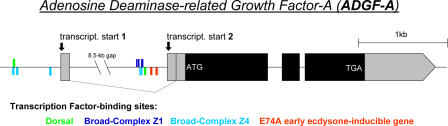
Schematic Map of the ADGF-A Gene with Promoter AnalysisThe ADGF-A gene contains four exons and two transcriptional starts [17,47]. We analyzed sequences preceding both transcriptional starts for the presence of known transcriptional factor binding sites using the software program Gene2Promoter (Genomatix Software GmbH). Selected sites are represented by color bars in approximate positions of promoter regions. The legend under the sequence show the names of transcription factors binding to matching colored binding sites.